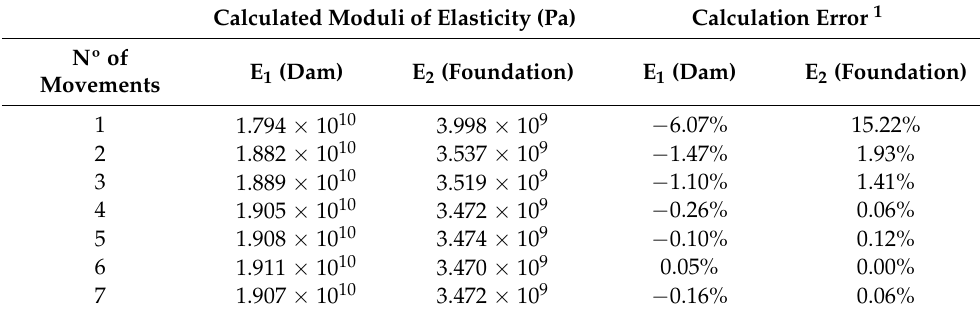
Table 1. Calibrated elasticity moduli for sectorization 1: dam and homogeneous foundation.